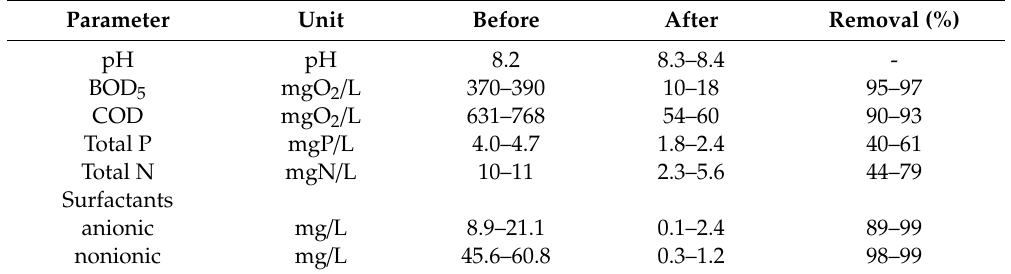
Table 1. Composition of laundry wastewater before and after biological